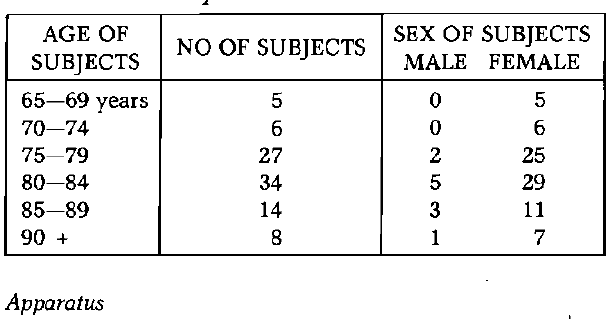
Table 1: The age-spread and sex of subjects used